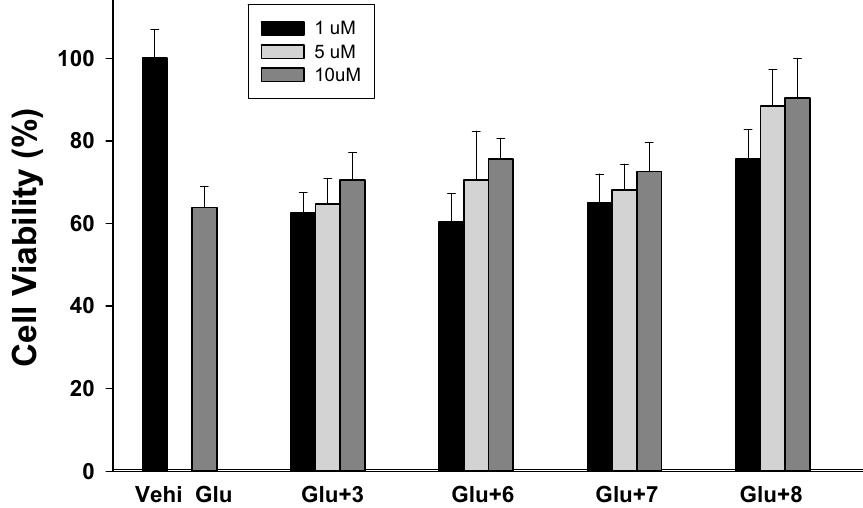
Figure 6. Inhibition of glutamate-induced neurotoxicity in cultured cortical neurons. Glutamate alone or with (60 µM), compounds 3 and 6 – 8 were applied for 24 h at 37 °C. After incubation of neurons with WST-1 for 2 h and quantified spectrophotometrically. All values represent the mean ± SE of three-independent experiments performed in triplicate.